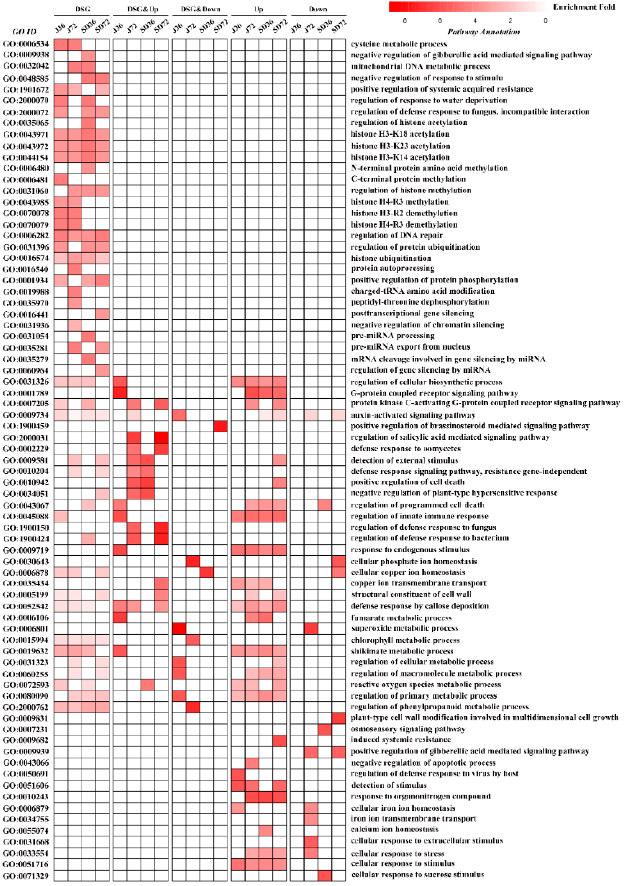
Figure 9. The heatmap showing the GO terms enrichment analysis of DSG-specific, DEG-specific and DSG and DEG-overlapped AS genes. DSG: DSG-specific genes; DSG&Up: AS genes were both differentially spliced and upregulated; DSG&Down: AS genes were both differentially spliced and downregulated; Up: AS genes only were upregulated; Down: AS genes only were downregulated. The color scale represents enrichment folds of different GO terms (FDR < 0.05).